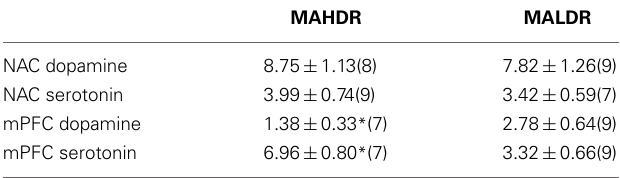
The data represent the mean ± s.e.m. of 3 dialysate samples, collected dur- ing the hour prior to a methamphetamine injection. The number of animals employed in the statistical analyses of the data is indicated in parentheses.